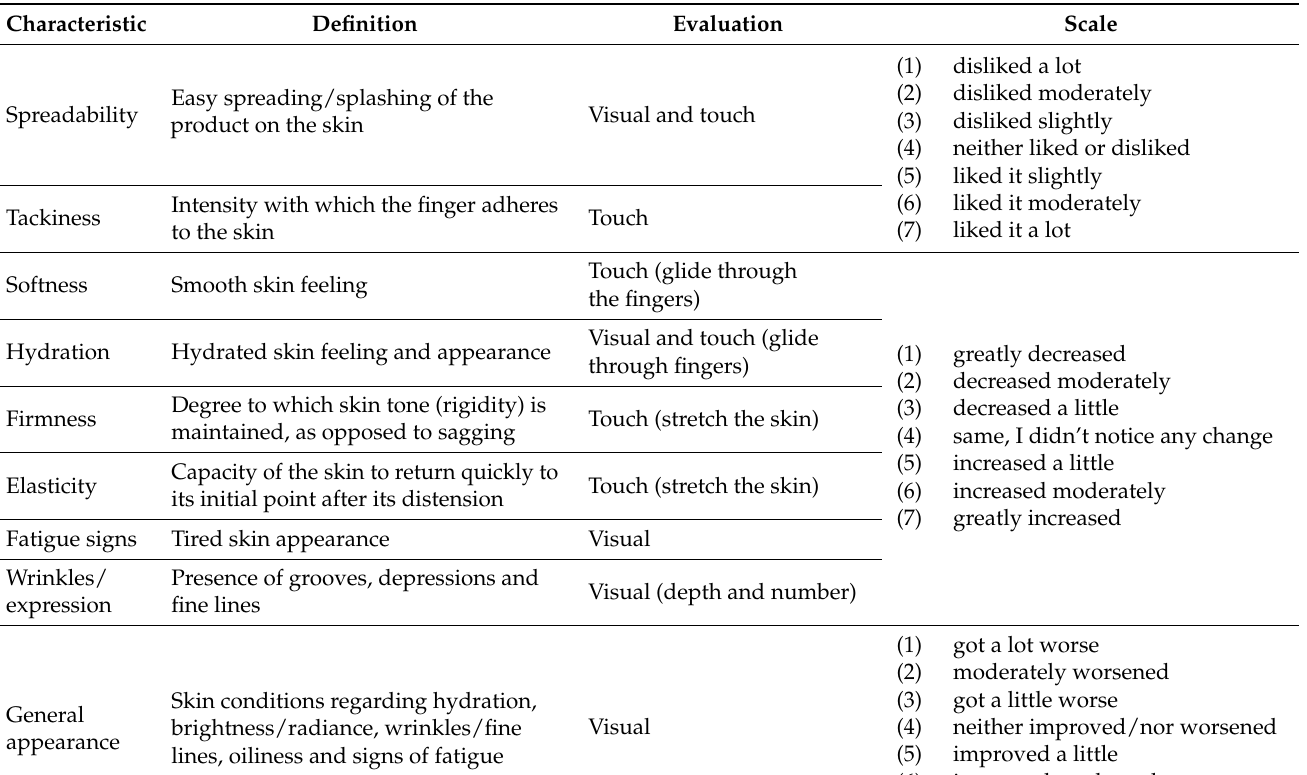
Table 2. Definition of characteristics, evaluation form, and